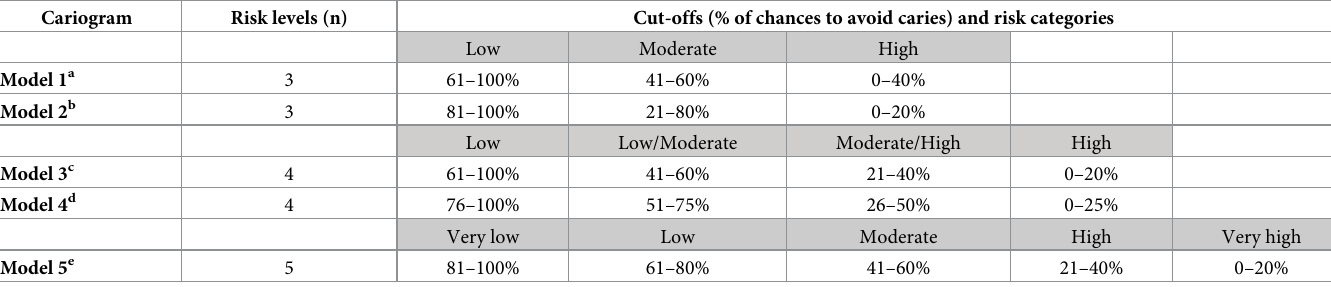
Table 1. Cariogram models and cutt-off values